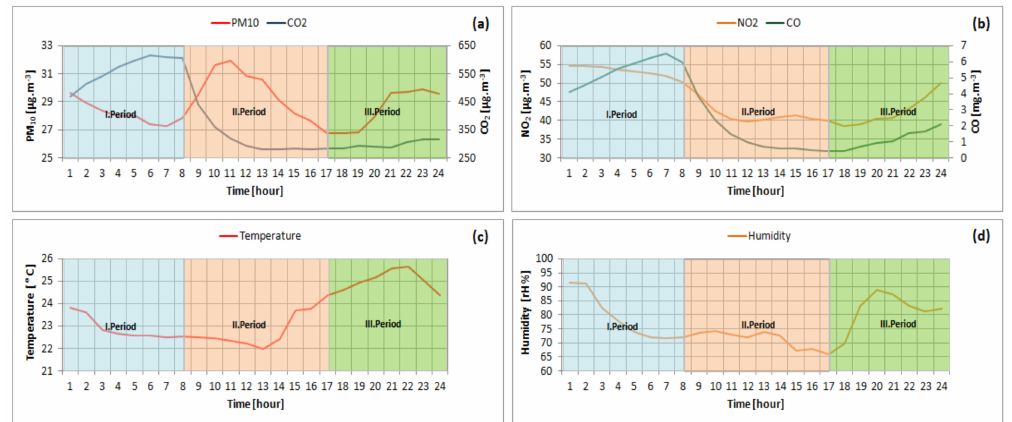
Figure 5. Daily changes of PM and gases, ( a ) PM 10 , ( b ) CO 2 , ( c ) CO, ( d ) NO 2 .